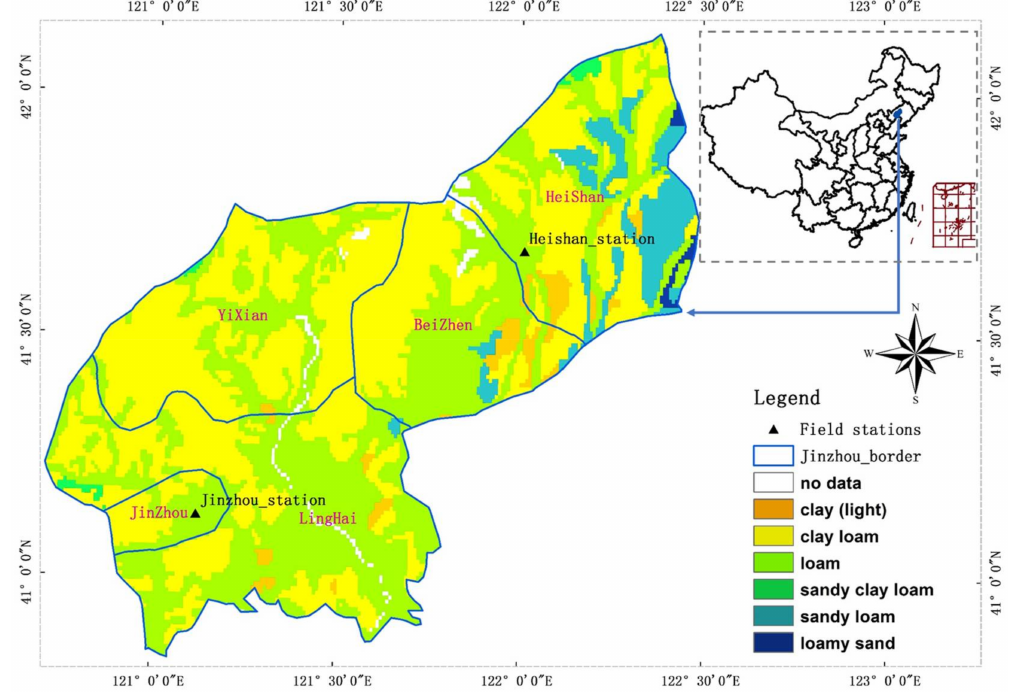
Figure 1. Study area and field stations